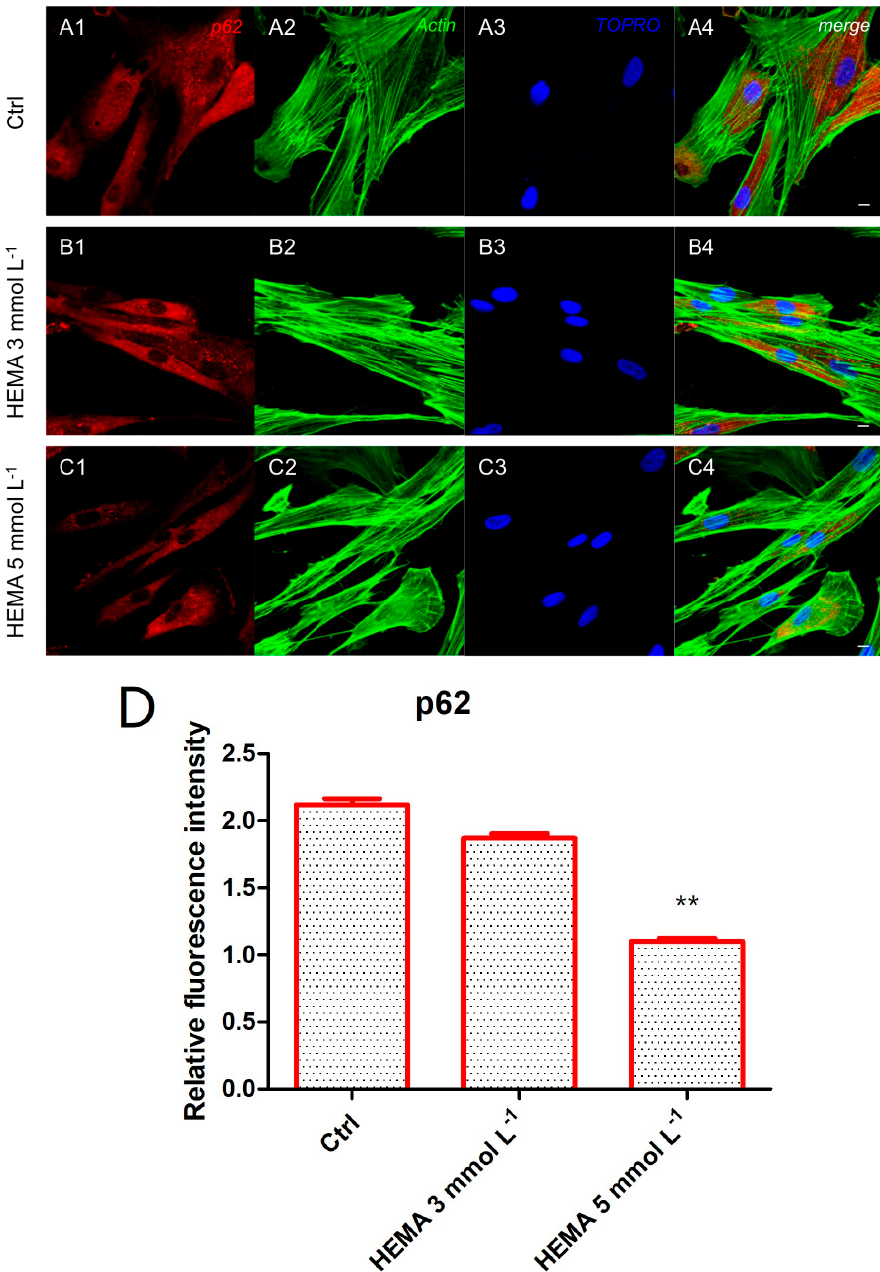
Figure 4. p62 expression. ( A1 ) Untreated cells showed a strong positive expression for p62 marker. ( A2 ) Actin cytoskeleton in untreated hDPSCs. ( A3 ) Nuclei in untreated hDPSCs. ( A4 ) Merged picture of abovementioned channels in untreated hDPSCs. ( B1 ) Cells treated with HEMA 3 mmol L − 1 showed a positive expression for p62 marker. ( B2 ) Cytoskeleton actin in HEMA 3 mmol L − 1 p62 treated hDPSCs. ( B3 ) Nuclei in HEMA 3 mmol L − 1 treated hDPSCs. ( B4 ) Merged picture of abovementioned channels in HEMA 3 mmol L − 1 treated hDPSCs. ( C1 ) Cells treated with HEMA 5 mmol L − 1 showed a low positive expression for p62 marker. ( C2 ) Actin cytoskeleton in HEMA 5 mmol L − 1 treated hDPSCs. ( C3 ) Nuclei in HEMA 5 mmol L − 1 treated hDPSCs. ( C4 ) Merged picture of abovementioned channels in HEMA 5 mmol L − 1 treated hDPSCs. ( D ) The relative fluorescent intensity of p62 was analyzed using NIS-Elements AR imaging software. Data are presented as the mean of thirty measurements ± standard deviation. ** p < 0.01. Green fluorescence: actin cytoskeleton, red fluorescence: p62, blue fluorescence: nuclei. Magnification: 63×. Scale bar: 10 μ m.